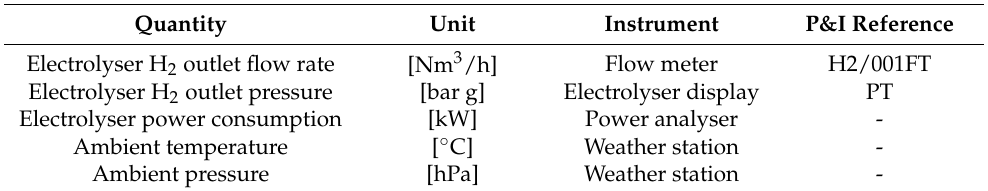
Table 7. Quantities measured during the hydrogen production efficiency test with unit of measure- ment, instrument used for the survey and reference to the position on the P&ID of Figure